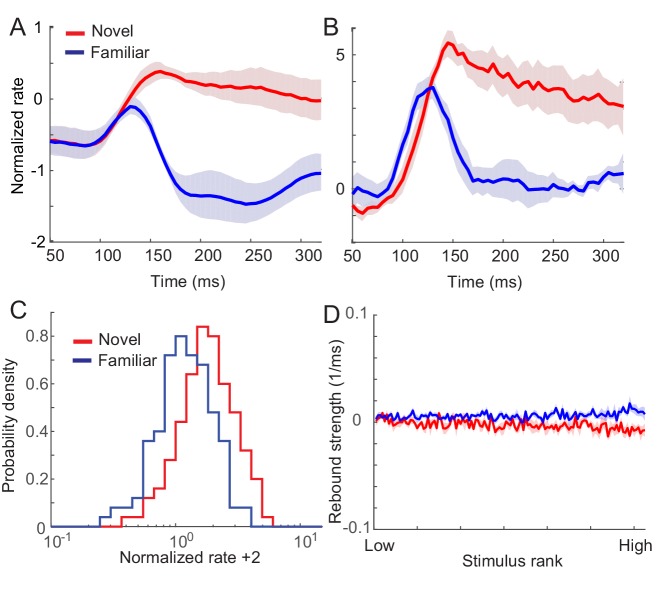
Changes in response dynamics of putative inhibitory neurons with learning in a passive viewing task (Woloszyn and Sheinberg, 2012).(A, B) Average (A) and maximal (B) response to familiar (blue) and novel (red) stimuli. (C) Distributions of time-averaged activities. (D) Rebound strengths in inhibitory neurons before and after learning. Activities and rebound strengths were quantified in the same manner as in the excitatory neurons in Figure 1.